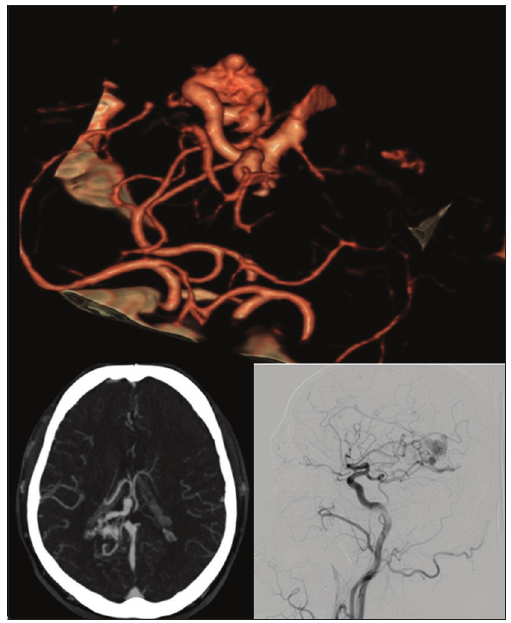
FIGURE 1. Correlation between computed tomography angiog- raphy (CTA) volume rendering, CTA intense maximum projec- tion, and DSA findings in a 34-year-old male with arteriovenous